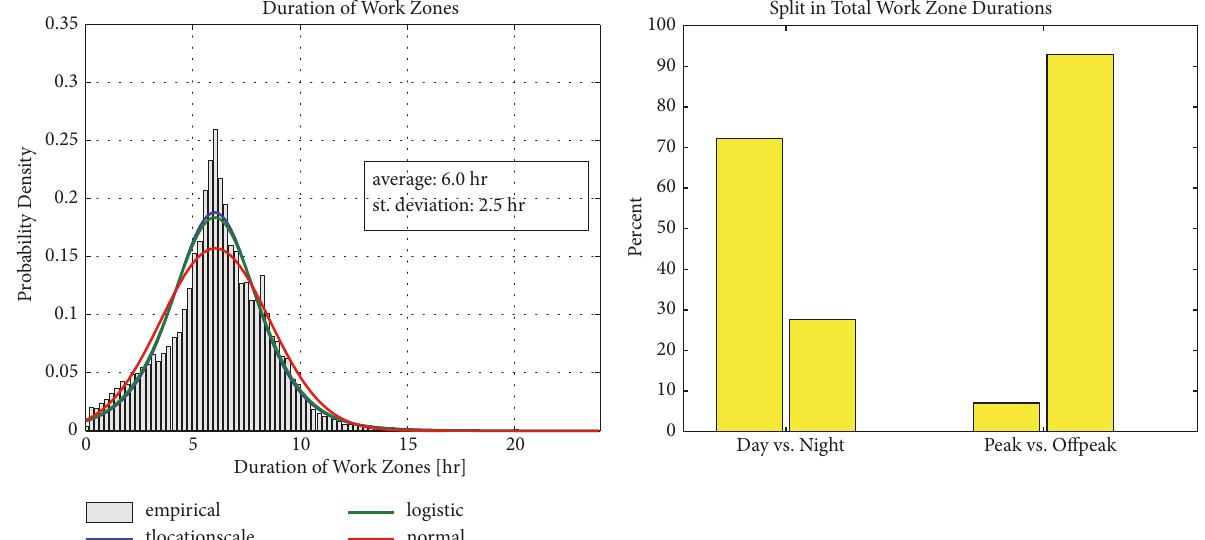
Figure 3: Duration of WZs and split in total work zone hours in day/night and peak/off-peak. Seventeen continuous distributions were fitted to WZ duration [74], and the probability density functions of those distributions that best fit in terms of Bayesian information criterion are shown in the figure on the left. Sunrise and sunset times for the dates of maintenance work and geographic locations of WZs are computed using Matlab toolbox from SCRIPPS Institute of Oceanography [75].